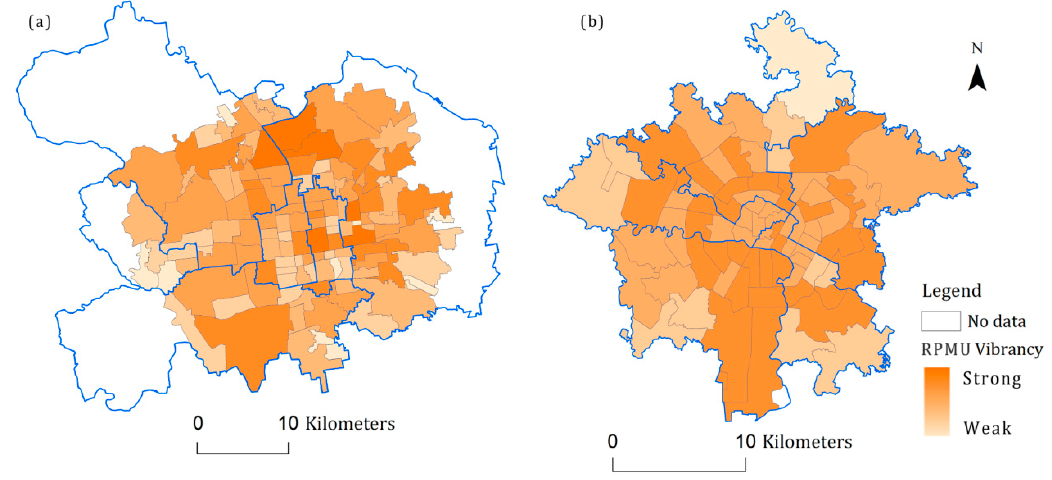
Figure 3. Spatial distribution patterns of neighborhood vibrancy. ( a ) Beijing, ( b ) Chengdu.